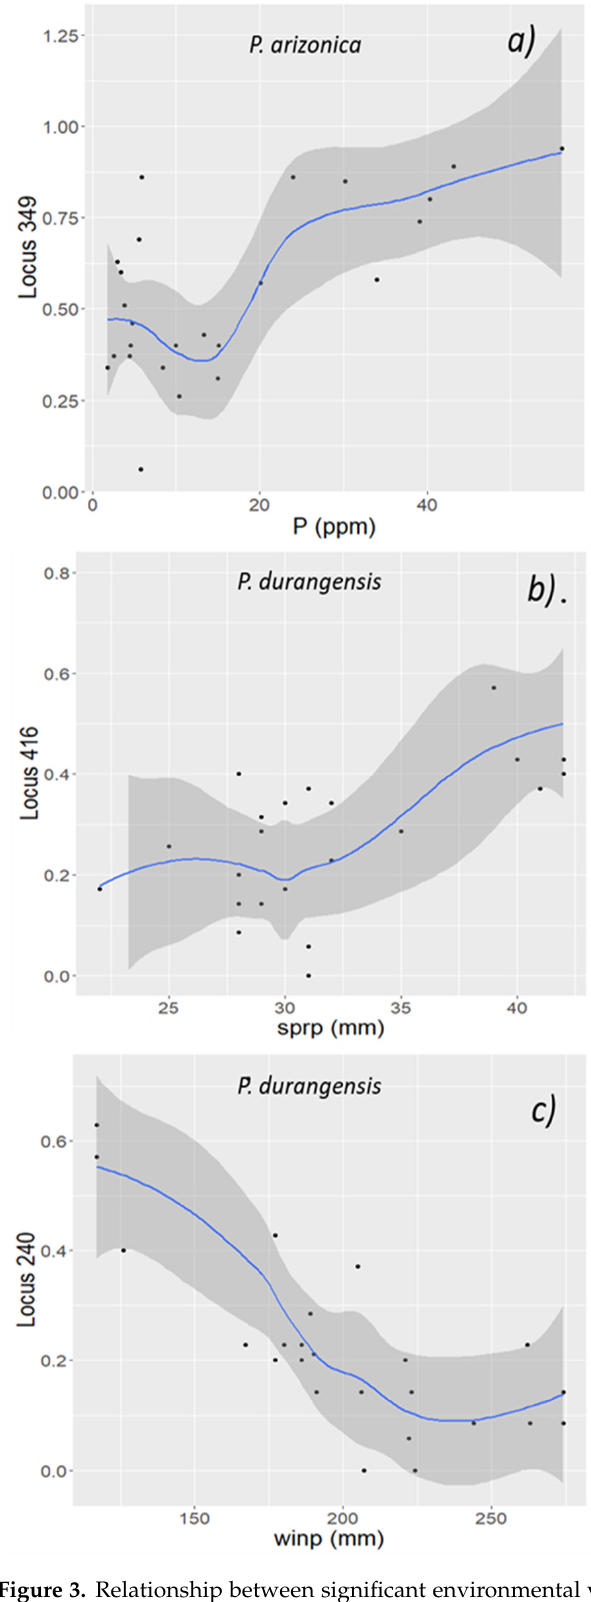
Figure 3. Relationship between significant environmental variables and the relative frequency of selected AFLP outliers for Pinus arizonica ( a ) and P. durangensis ( b , c ), the mean (blue line) and standard deviation (grey area) are based on generalized additive models (GAM).